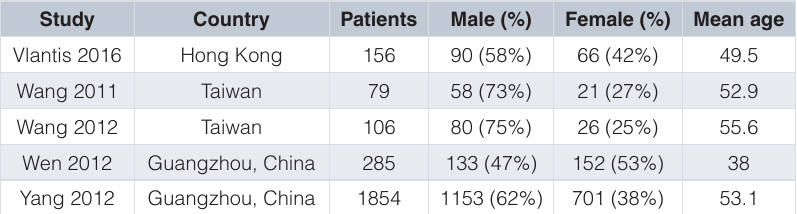
Table 1. Demographics of included studies.